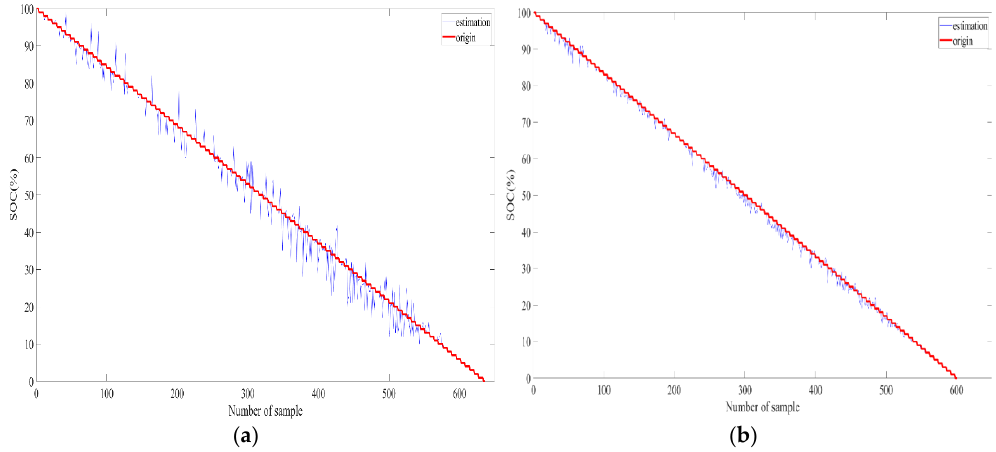
Figure 11. SOC estimation results; ( a ) using the LSTM utilizing only six voltage as the input value and the temperature variable data at room temperature; ( b ) using the LSTM utilizing only 6 voltage as the input value and the temperature variable data at high.